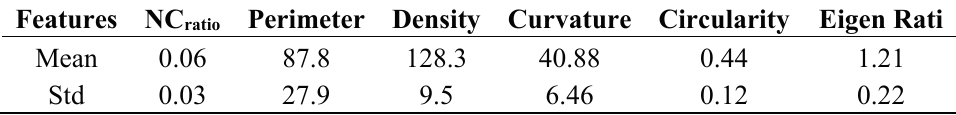
Table 3. Mean and standard deviation for the benign sputum cell.